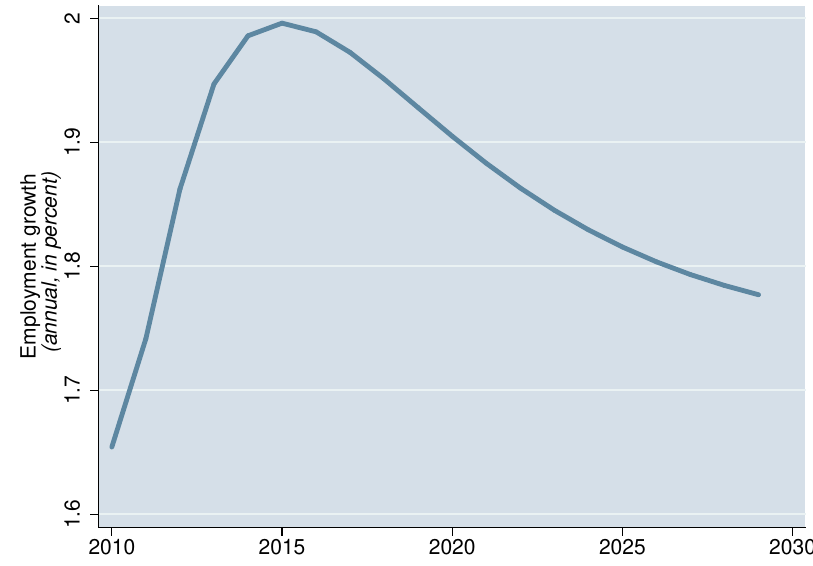
Figure 6: Employment dynamics with unreformed financial markets